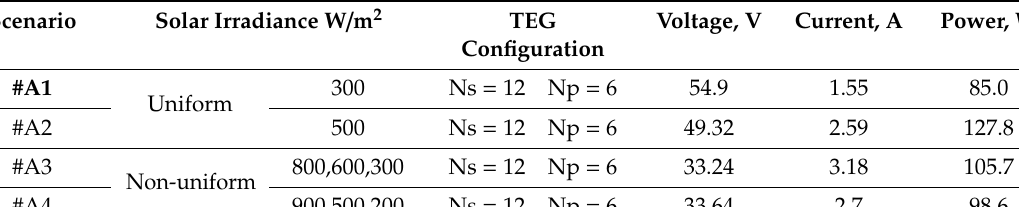
Table A1. Voltage, current and power at MPP under different scenarios.